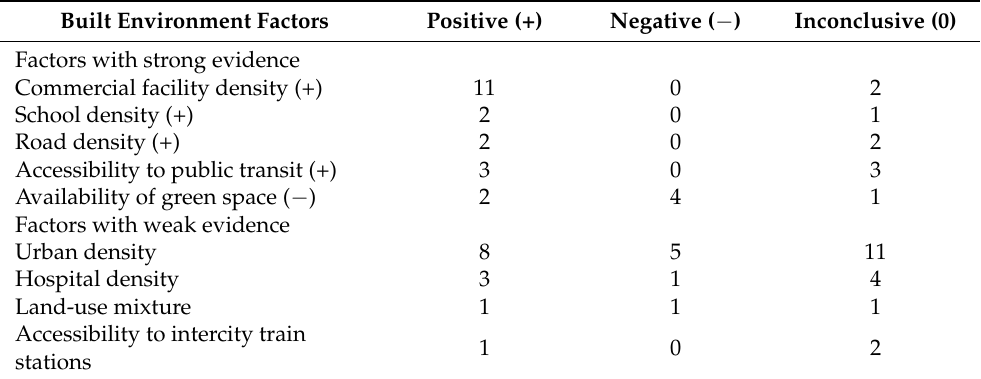
Table 2. Summary of associations between built environmental factors and coronavirus disease 2019